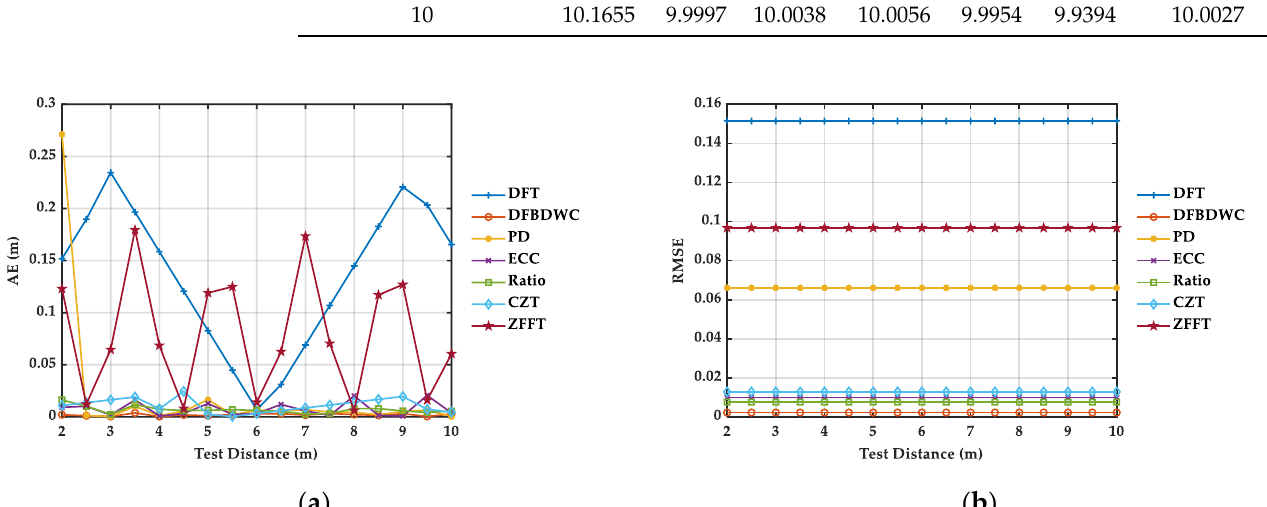
Figure 7. Simulation results of seven algorithms comparison at different distances. There are WGN signals with SNR of 10 dB in s B ( n ) . ( a ) is AE . ( b ) is RMSE